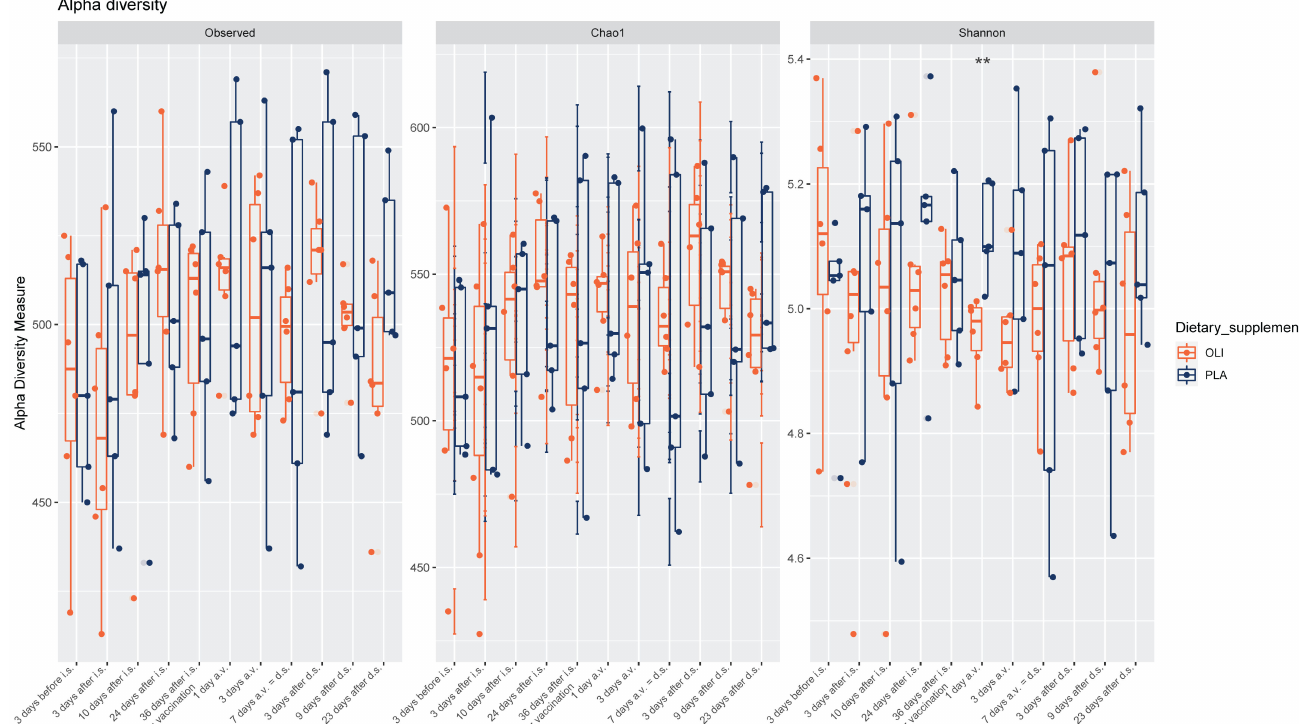
Figure 2. Box-plots showing Observed, Chao1 and Shannon index in fecal samples of horses depending on groups (OLI = Olimond, PLA = Placebo) separately for each sampling time (i.s. = introduction of the supplement, a.v. = after vaccination, d.s. = discontinuation of the supplement). **: p -value < 0.01.